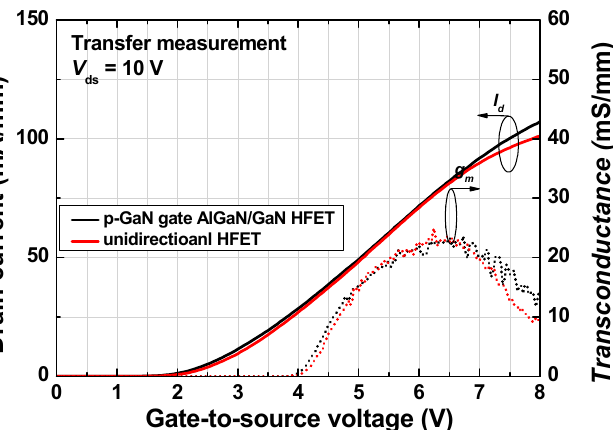
Figure 7. Transfer current–voltage characteristics of fabricated p-GaN gate AlGaN/GaN HFET (black line) and unidirectional HFET (red line).